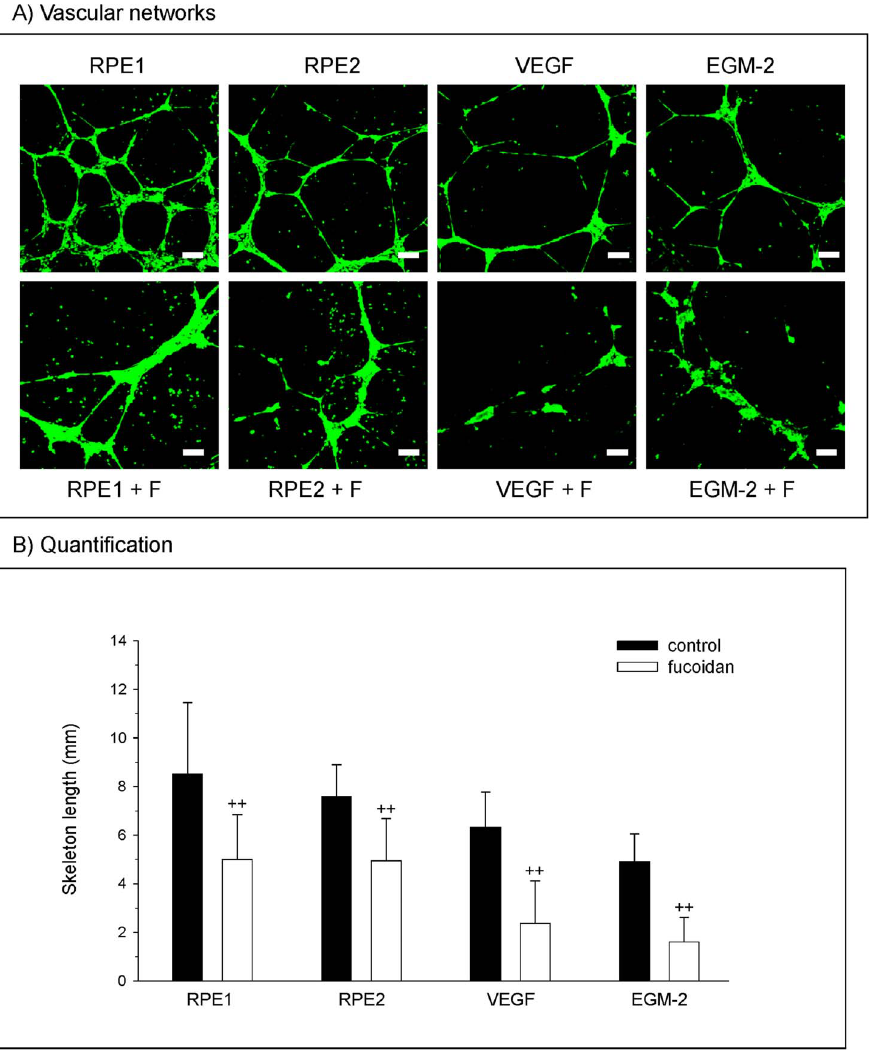
Figure 7. Angiogenesis. (A) Morphological appearance of OEC grown on Matrigel and stained with Calcein-AM which is converted to a green fluorescence by viable cells. Results indicated angiogenic structures in OEC treated with conditioned medium from RPE cells from different donors, VEGF and the EGM-2 (no VEGF). Additional treatment with fucoidan resulted in the reduction of vascular structures. (B) Quantitative image analysis depicting the skeleton length of angiogenic structures. Significance was determined with student’s t-test, ++ p ,